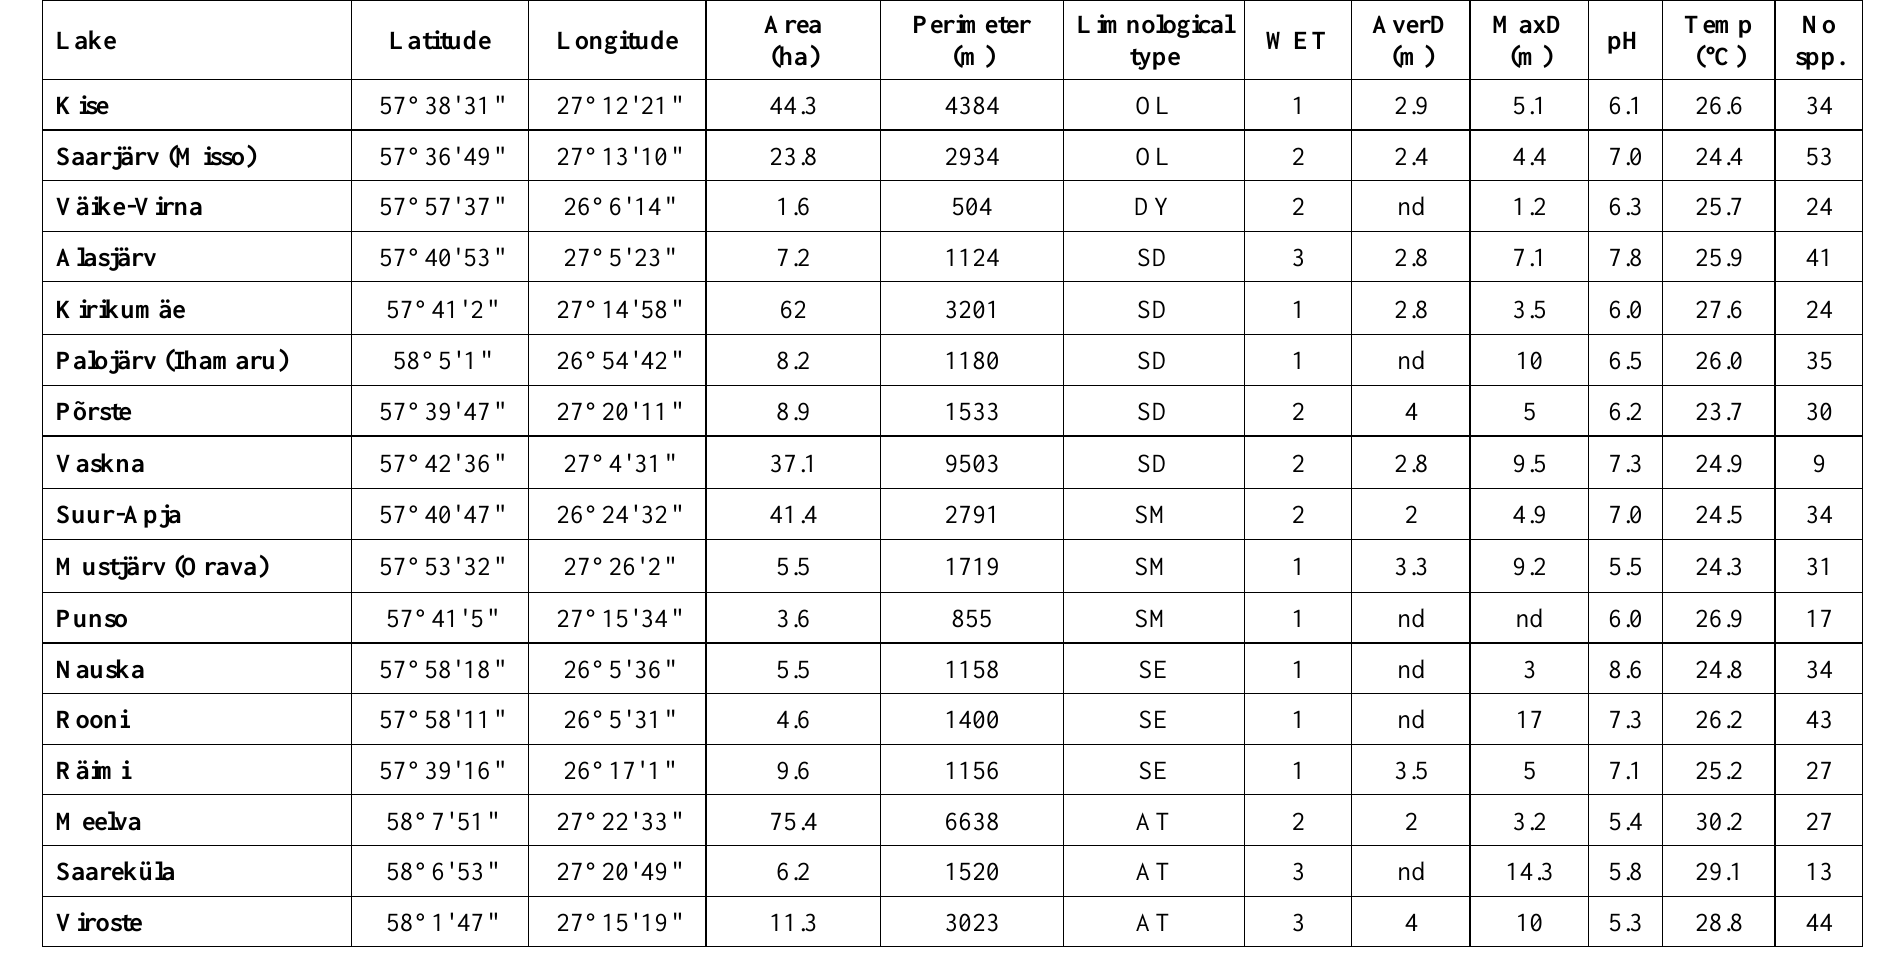
Table 1. Characteristics of the selected lakes. Notation: Latitude and Longitude = lake centre coordinates; Perimeter = lake shoreline length; Limnological type (OL = oligotropic, DY = dystrophic, SD = semidystrophic, SM = soft-water mixotrophic, SE = soft-water eutrophic (due to anthropogenic eutrophication), AT = acidotrophic). WET = lake water exchange type (1 = endorheic (seepage) lake, 2 = outflow lake, 3 = throughflow lake); AverD = average